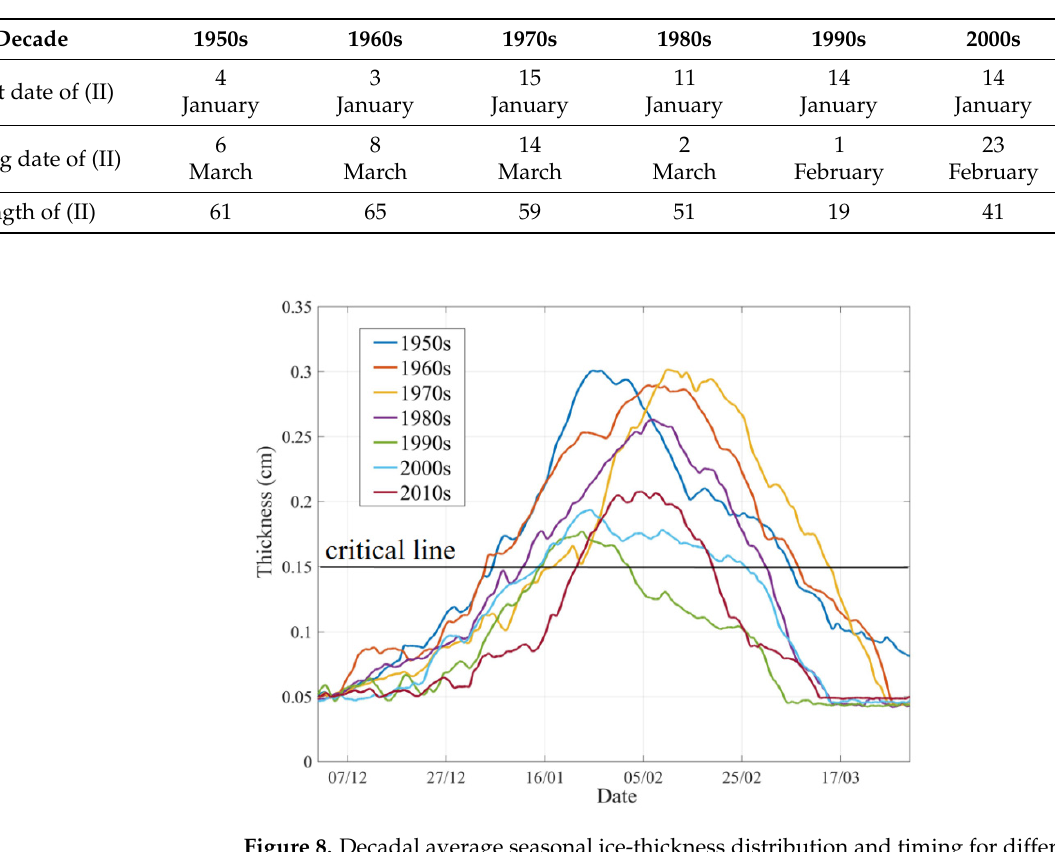
Table 5. Timing (onset and ending) and length of ( Ⅱ ) from the 1950s to the 2010s.